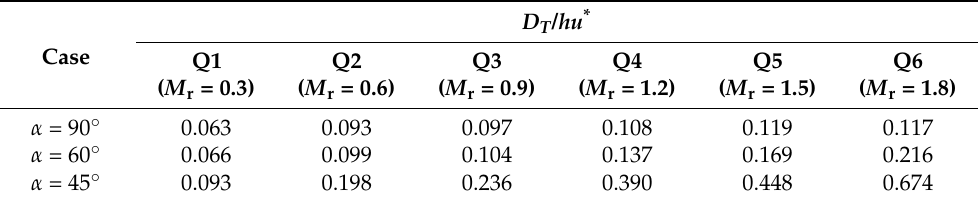
Table 3. Estimation results of transverse dispersion coefficient according to momentum ratio and confluence